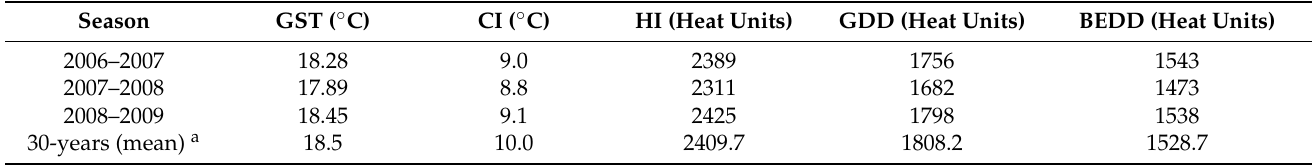
Table 1. Bioclimatic indices calculated for each season under